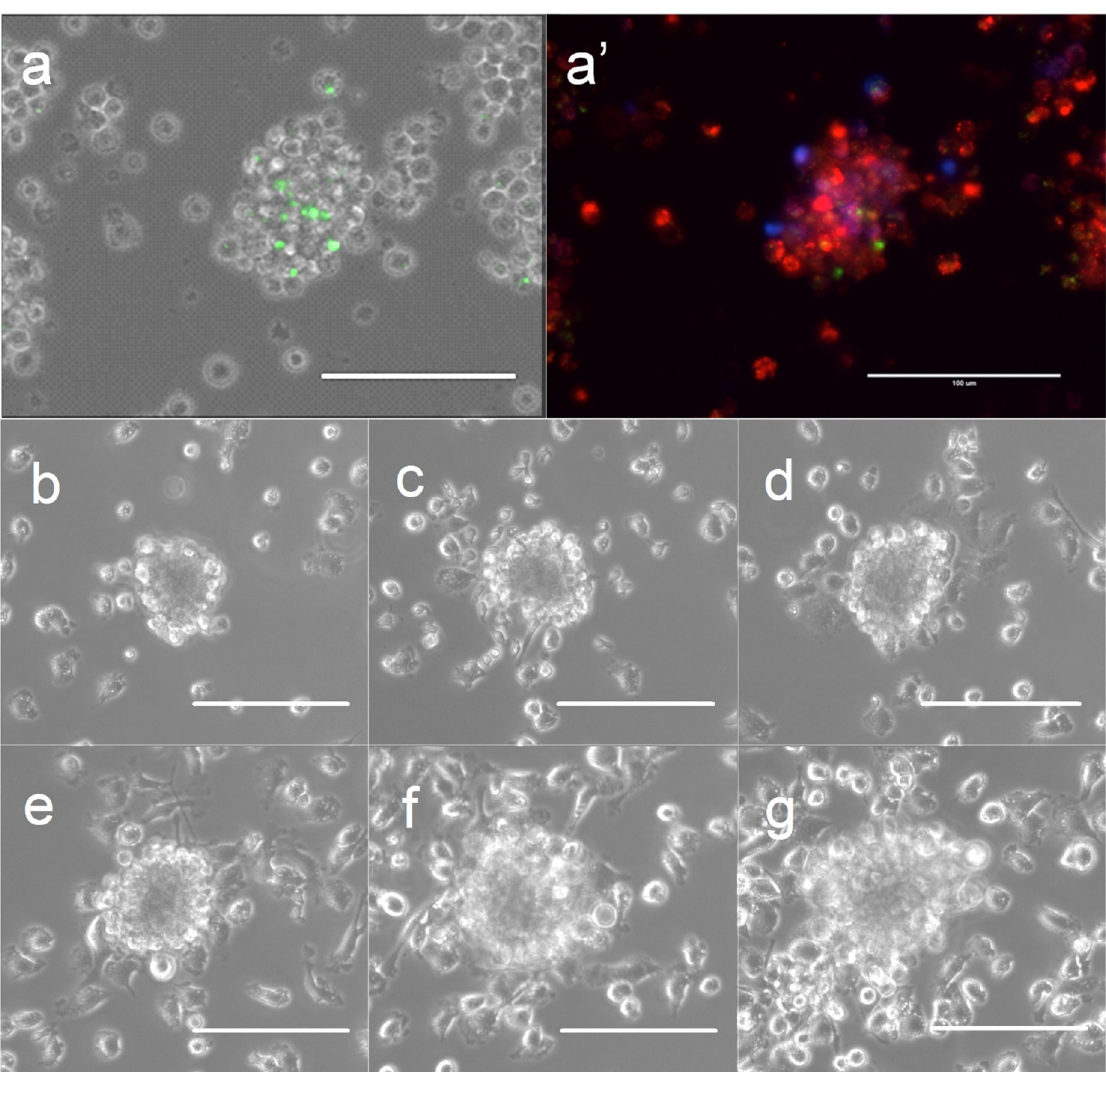
Figure 1. Formation of granuloma-like cell clusters (GLCCs) in vitro. ( a ) GLCC of macrophages and lymphocytes exposed to Map . ( a’ ) Same GLCC with superimposed fluorescence channels showing macrophages (red), lymphocytes (blue), and internalized Map (green). ( b–g ) Phase-contrast images of a single GLCC across the time-course at 1-day intervals (3–8 days post-infection; lymphocyte-free model). The scale is 100 µm.